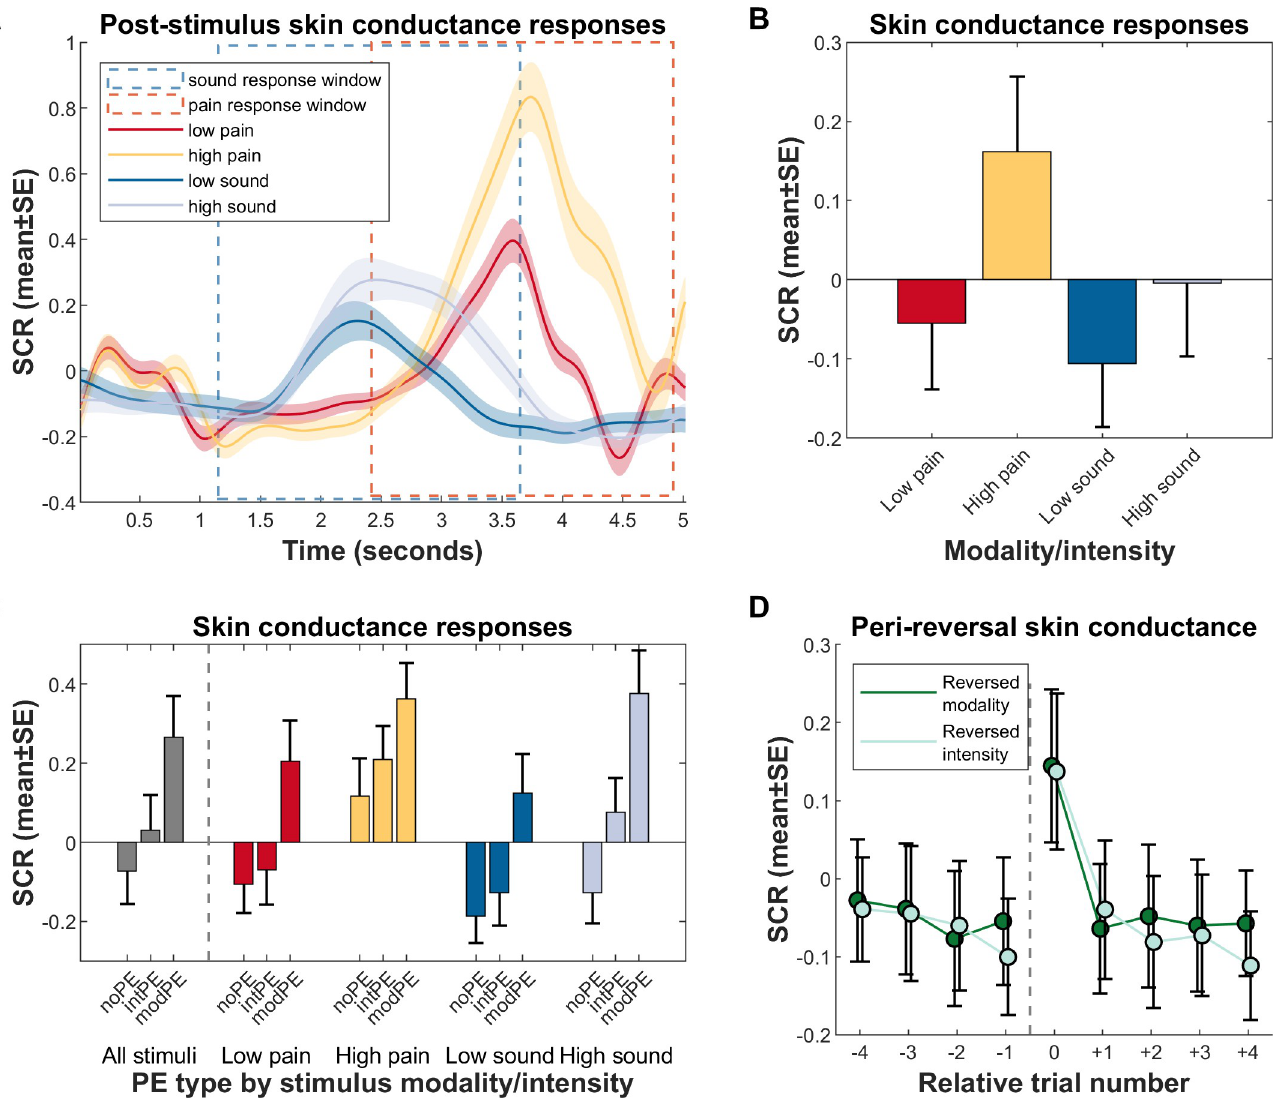
Fig 4. Results from SCR measurements. All plots are based on log- and z-transformed data. (A) SCR in relation to US onsets, by US modality/intensity. Note the differences in latencies between the 2 modalities (pain in red/yellow has a later onset, sound in dark blue/light blue earlier), which determined the response windows used for mean SCR calculation in panel b. (B) Mean SCR by US, calculated within each modality’s response window. On average, SCR is not significantly different between modalities; differences arise between intensities, and in the interaction of modality and intensity (see text for parameters). (C) Mean SCR by US and PE type. Over all modalities and intensities, differences arise between each PE type. Within specific modality/intensity combinations, differences between no PEs and intensity PEs only arise in the high sound condition. (D) Mean SCR in and around reversal trials. Within trials, data are pooled over all modalities, intensities, and expectations, i.e., does not consider whether participants correctly predicted the subsequent stimulus. The dashed vertical line indicates contingency reversal, with relative trial number 0 as the reversal trial. SCR rises sharply after reversal, but quickly adapts postreversal to a stable level. Data used to produce the figure can be found at https://www.doi.org/10.17605/OSF.IO/7JBV3. intPE, intensity prediction error; modPE, modality prediction error; noPE, correct prediction; PE, prediction error; SCR, skin conductance response; US, unconditioned